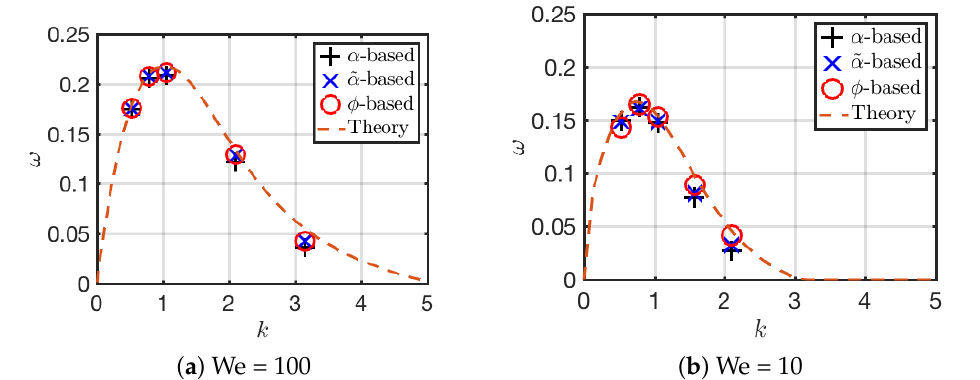
Figure 8. Comparison of the growth rate of the shear-layer instability against analytical solutions. Table 2. Percentage error (100 × predictions for We = 100.